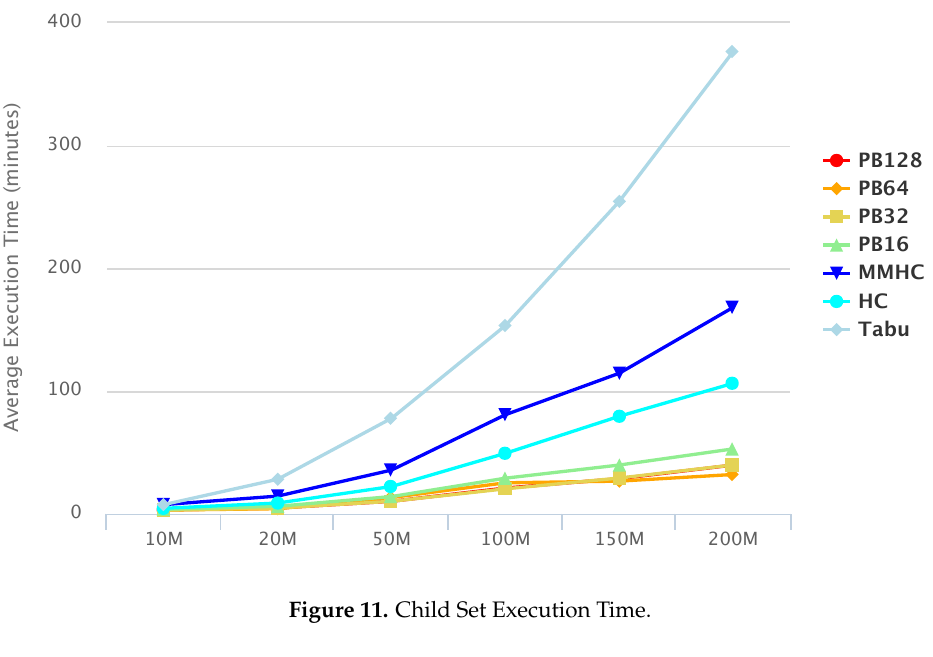
Figure 11. Child Set Execution Time.